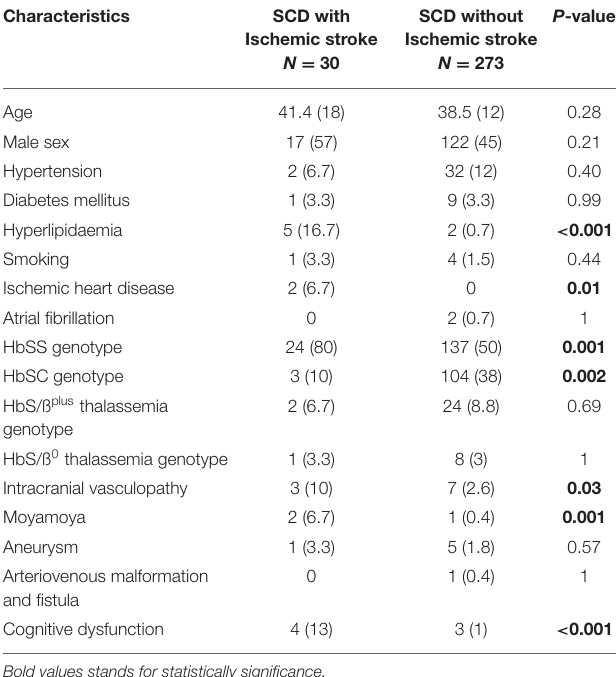
TABLE 3 | Ischemic stroke and cognitive impairment in the sickle cell disease cohort. Characteristics